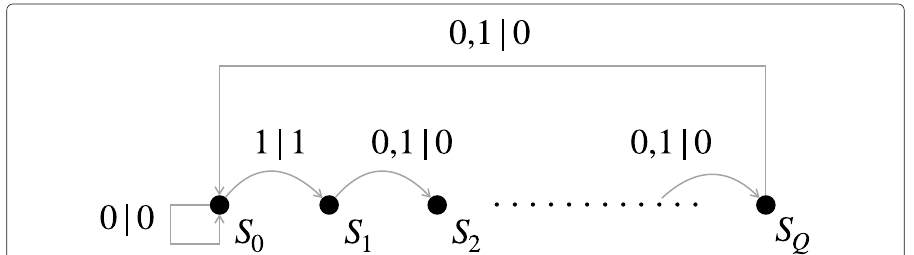
Fig. 3 State transition graph. The state S 0 will be named “active” and other states “passive”. When a channel is active, it transmits an input signal to the output. After signal transition, the channel will be passive during the Q time